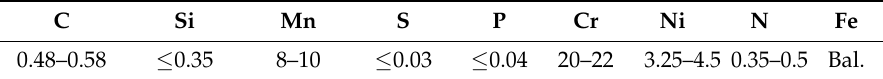
Table 1. Chemical composition of the 21-4N sheet